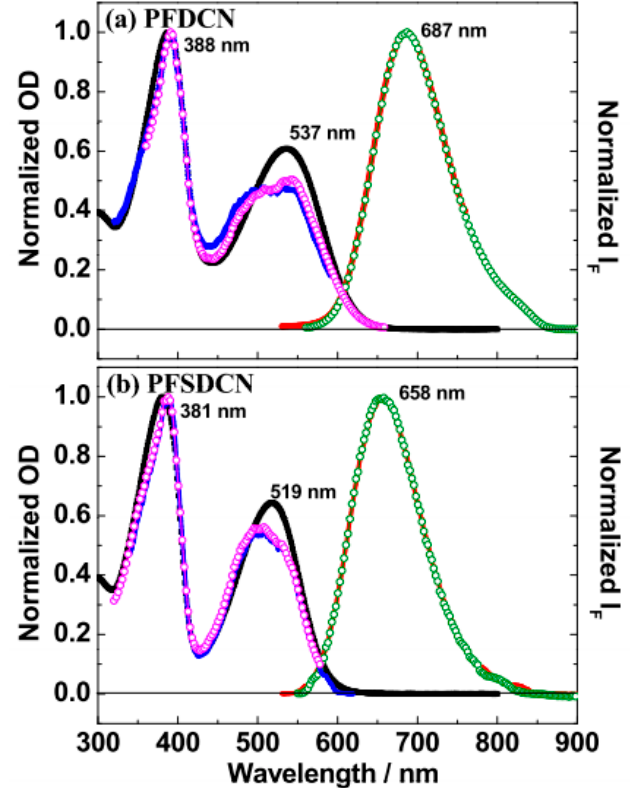
Figure 1. Steady-state spectra of PFDCN ( a ) and PFSDCN ( b ) in chlorobenzene solution. The absorption spectra (black line), The fluorescence spectra with 390 nm and 540 nm excitation for PFDCN, 380 nm and 520 nm excitation for PFSDCN (red line and green line), the fluorescence excitation spectra probed at 610 nm and 690 nm (blue and magenta).